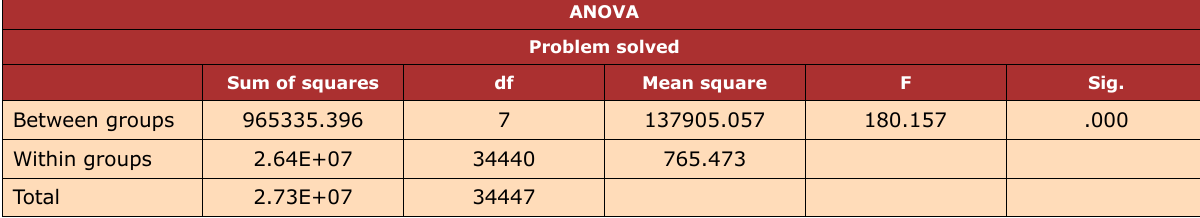
Table 2. ANOVA for all profiles solving